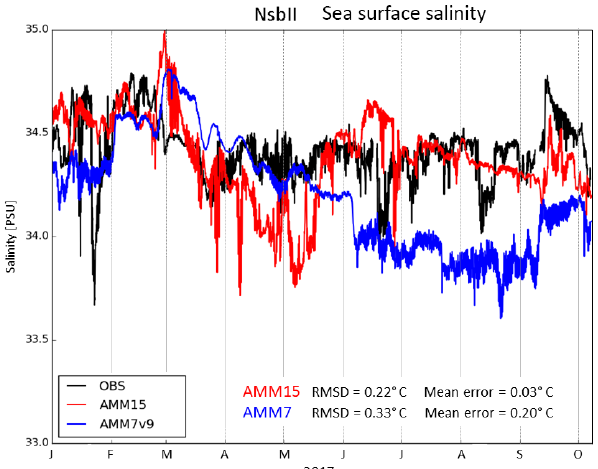
Figure 12. Observation minus model temperature (a) and salin- ity (b) profile assessment for AMM15 (black) and AMM7 (blue) for the whole domain. The RMSD is shown by the solid lines and mean error (observation–model) is shown by the dashed lines.